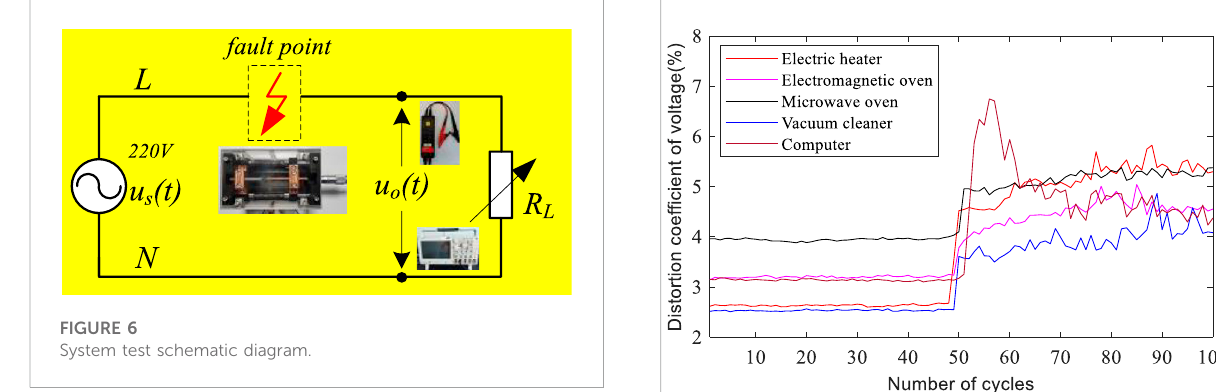
FIGURE 7 Comparison of voltage distortion coef fi cients of pre-fault and